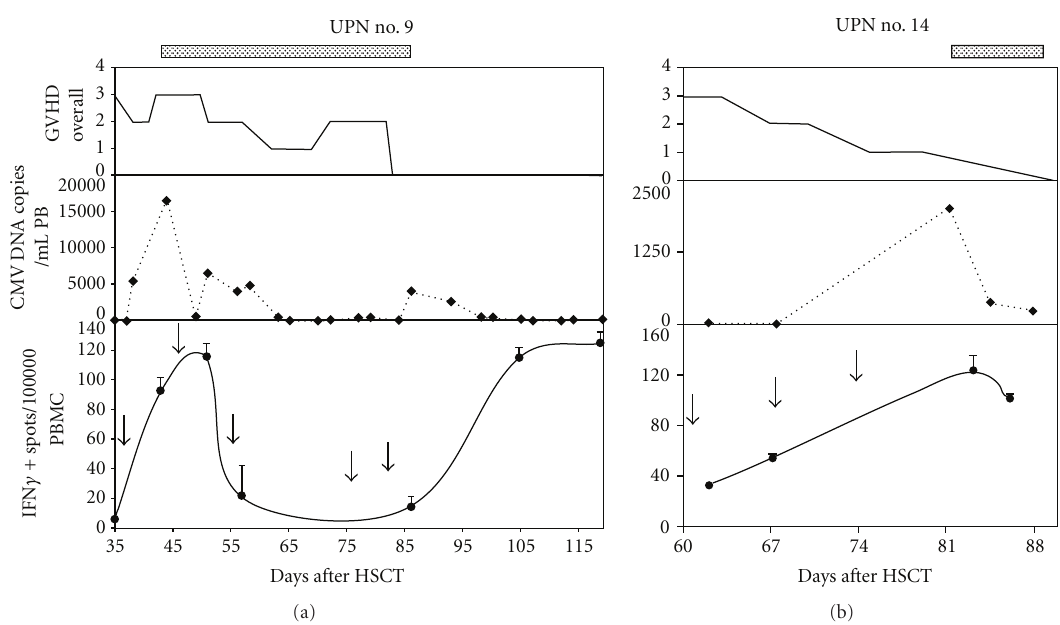
Figure 1: Frequency of CMV-specific T cells, secreting interferon gamma (IFN- γ ) in response to a cocktail of CMV-specific peptides, as measured by ELISPOT assay in two patients reactivating CMV after having received mesenchymal stem cells (MSCs) for the treatment of steroid refractory graft versus host disease. Dotted lines on top of the panels indicate Ganciclovir administration. In the upper panel overall GvHD grading according to NIH criteria is shown. In the central panel Cytomegalovirus (CMV) reactivation trend as measured in copies/milliliter of peripheral blood (PB) is shown. In the lower panel the number of CMV-specific IFN- γ producing cells in relation to MSC infusions as measured in IFN- γ spots/100.000 peripheral blood-mononucleated cells (PBMC) is shown. Black arrows indicate MSC